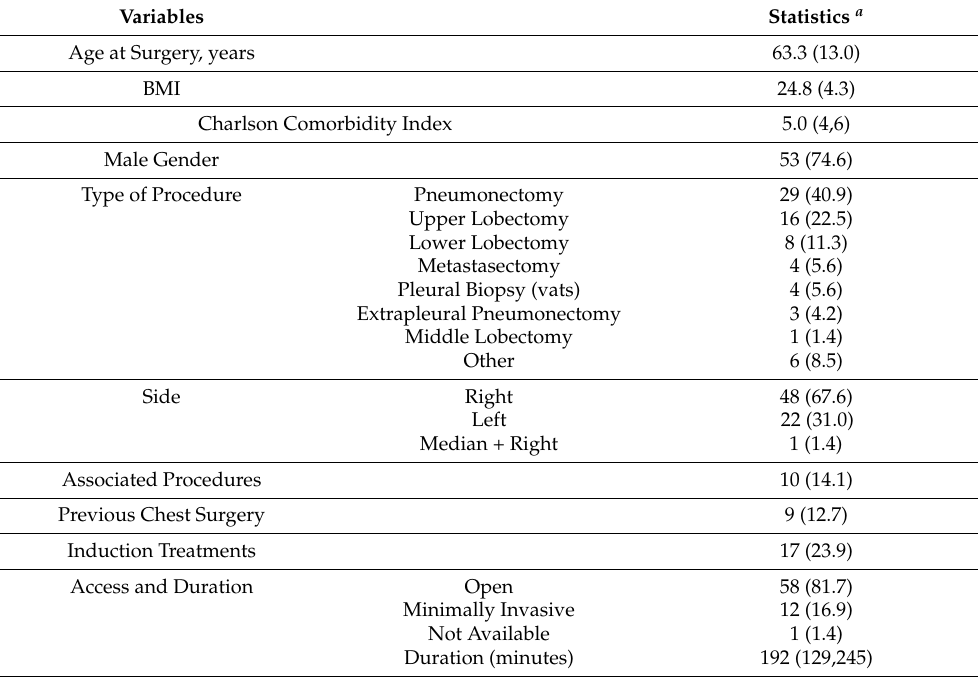
Table 1. Patients’ demography, treatments and procedures summary statistics, N = 71.